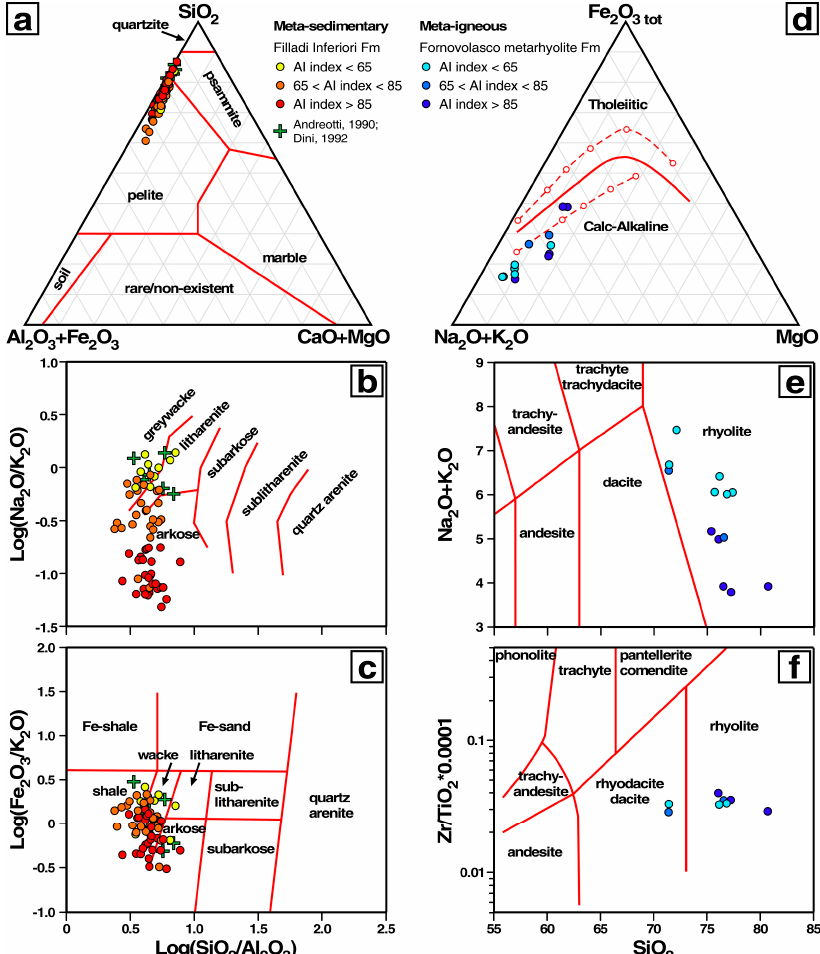
Figure 5. Classification diagrams for metasedimentary ( a – c ) and magmatic rocks ( d – f ) with data from “Filladi Inferiori” and Fornovolasco Metarhyolites Fms, respectively. ( a ) Ternary diagram modified from Turekian [50]. ( b , c ) Classification diagrams from Herron [51]. ( d ) Ternary AFM diagram from Irvine and Baragar [52]. ( e ) TAS diagram from Le Bas et al. [53]. ( f ) Zr/TiO 2 × 0.0001 vs SiO 2 diagram modified from Winchester and Floyd [54].